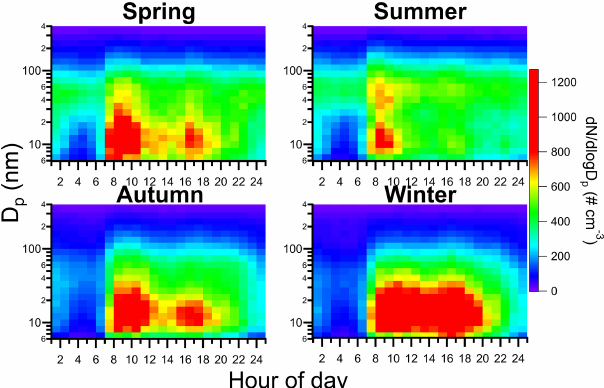
Figure 8. Hourly variation in median particle number size distri- butions over the different seasons of the year (note that D p corre- sponds to the particle’s mobility